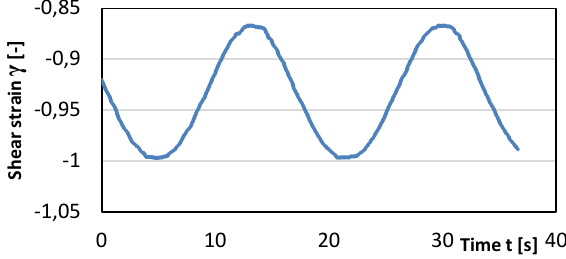
Fig. 3 Shear strain example of the interlayer during DMTA.